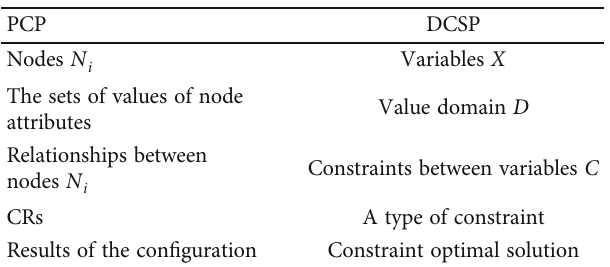
Table 4: Conversion of the corresponding elements of PCP and